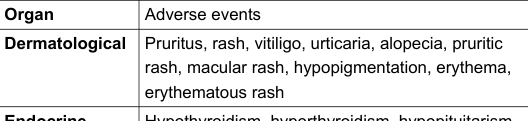
Table 2: Frequent immune-related adverse events reported with immune checkpoint inhibitors. Adapted from Davies et al. [69].